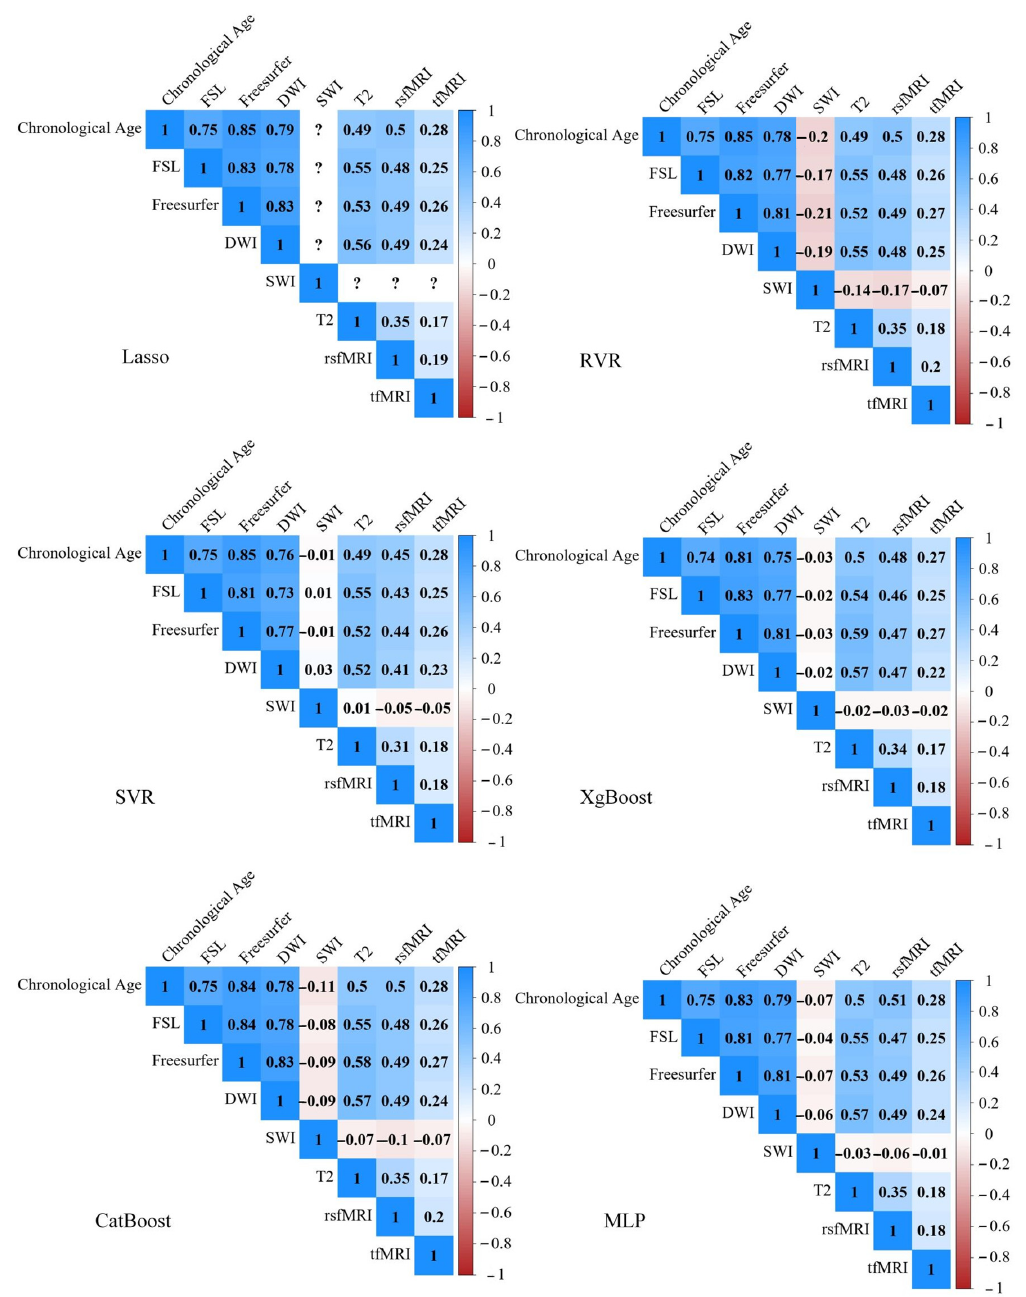
Figure 3. Pearson correlation matrix of chronological age and estimated brain age of six imaging modalities via six ML algorithms.